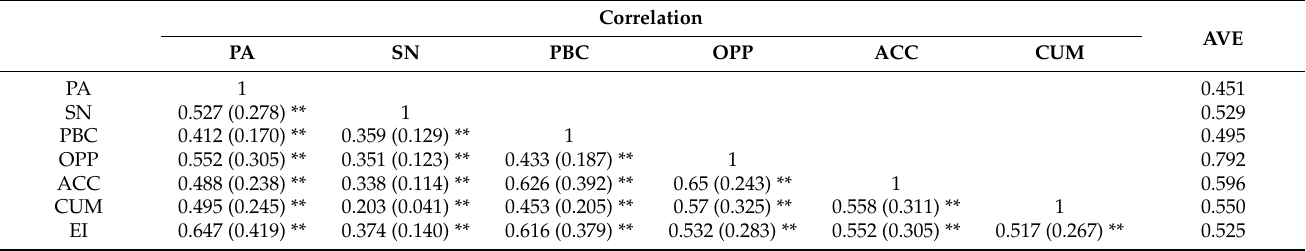
Table 4. Discriminant validity